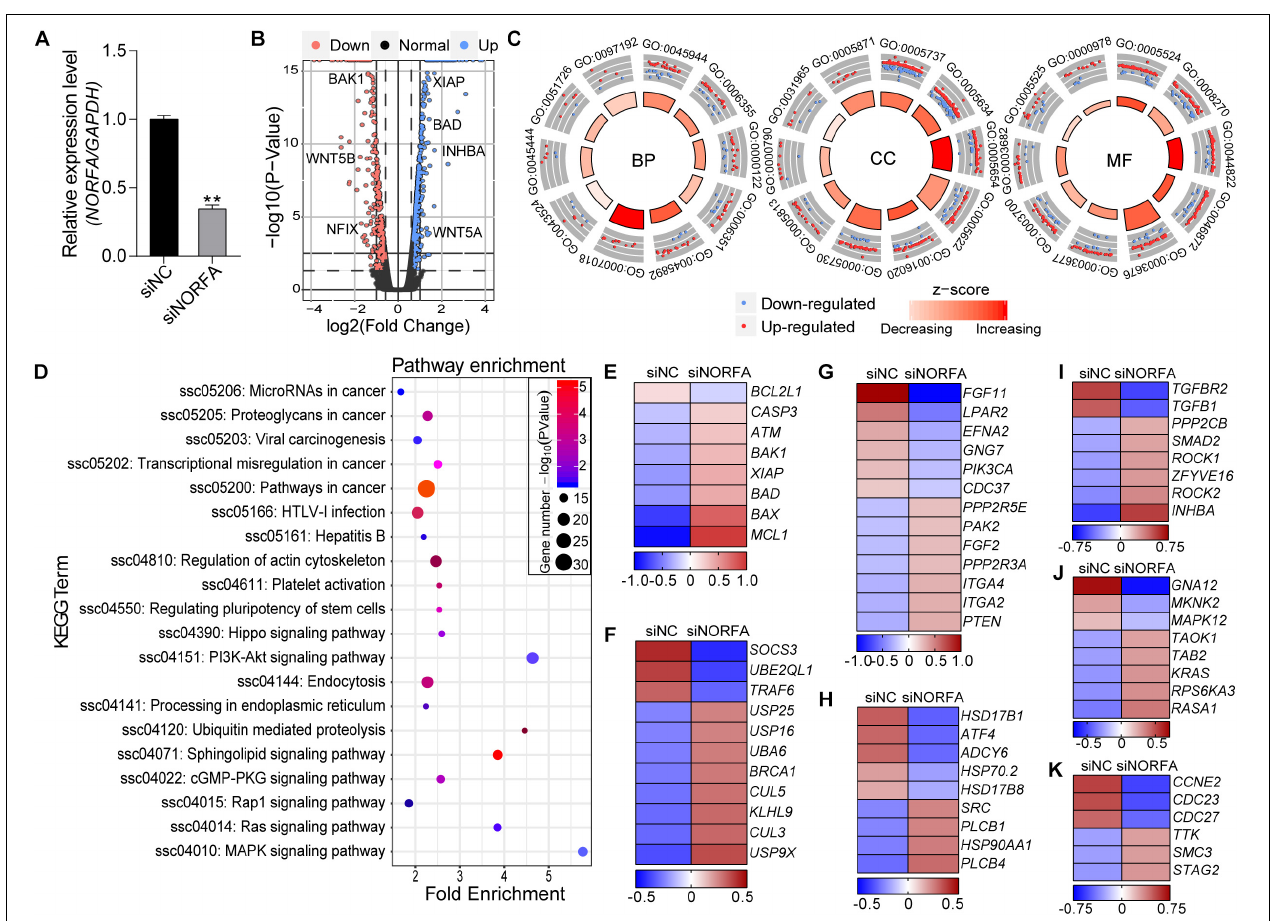
FIGURE 2 | Identification and functional assessment of DEmRNAs in NORFA -reduced porcine GCs. (A) The expression level of NORFA in porcine GCs after treatment with siNORFA was detected by qRT-PCR ( n = 3). (B) Volcano plot representing the expression profile of DEmRNAs in NORFA -reduced porcine GCs with the criteria of FDR < 0.05 and |Log 2 (fold change)| ≥ 0.59. Blue and pink points indicate up- and down-regulated genes, while the normal genes are labeled in black. Several crucial DEmRNAs were also indicated in the volcano plot. (C) Gene Ontology (GO) analyses of the DEmRNAs in NORFA -reduced porcine GCs and top 10 GO terms in BP (biological process), CC (biological process), and MF (molecular function) categories were represented. Blue points in each term indicated down-regulated DEmRNAs, while red points indicated up-regulated DEmRNAs. The regulation trend of each term was estimated according to the z score, which ranges from light red (decreasing) to dark red (increasing). (D) KEGG analyses of the DEmRNAs in NORFA -reduced porcine GCs and the significant enriched KEGG terms were also presented. (E–K) Heatmaps showing the expression patterns of DEmRNAs in KEGG enriched pathways, apoptosis signaling pathway (E) , ubiquitin signaling pathway (F) , PI3K-Akt signaling pathway (G) , estrogen signaling pathway (H) , TGF- β signaling pathway (I) , MAPK signaling pathway (J) , and cell cycle signaling pathway (K) . The color scale of each heatmap ranges from blue (low expression) to red (high expression).